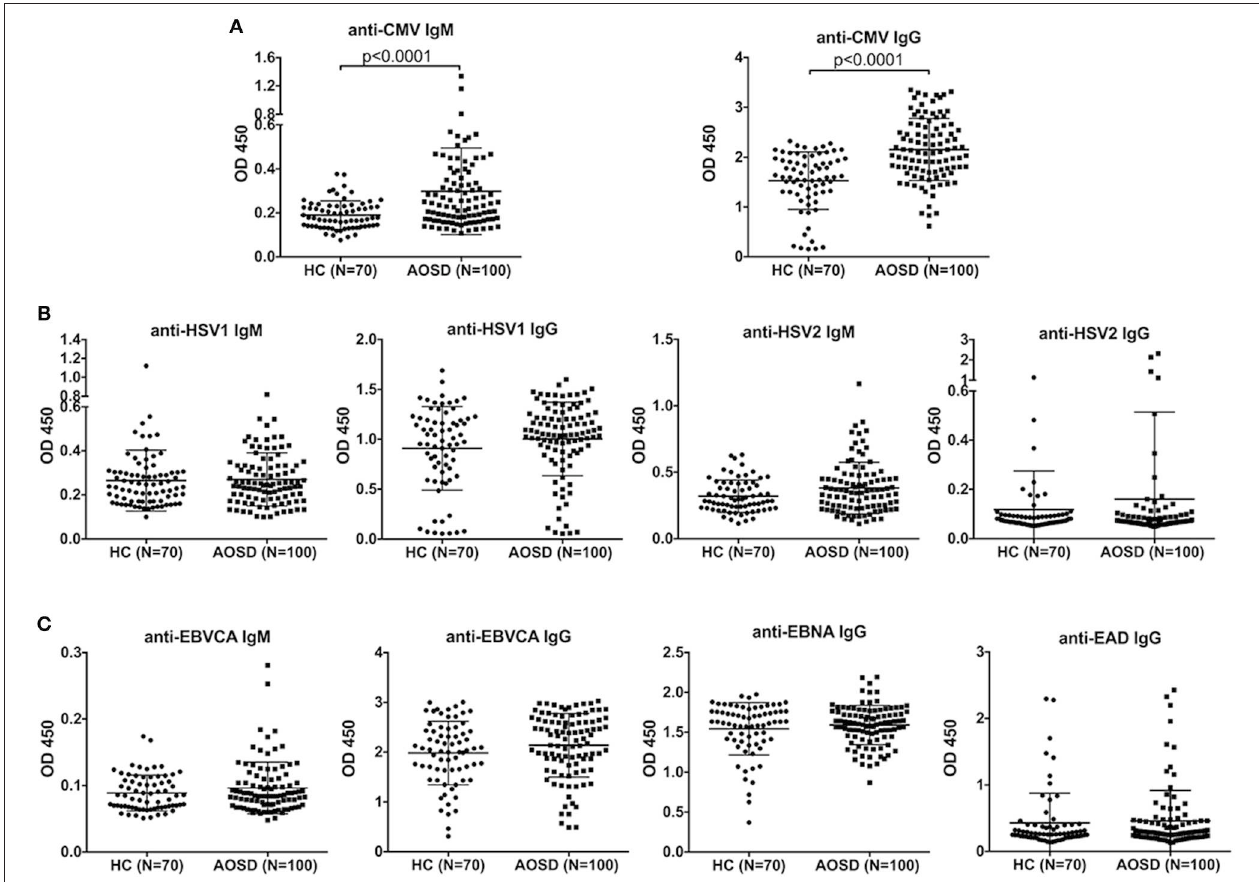
FIGURE 1 | Anti-virus antibody levels in AOSD patients ( N = 100) and HCs ( N = 70). (A) Comparison of antibody levels of anti-CMV IgM and IgG in AOSD patients and HCs. (B) Comparison of IgM and IgG antibody levels against HSV1 and HSV2 in AOSD patients and HCs. (C) Comparison of anti-EBVCA IgM, anti-EBVCA IgG, anti-EBNA IgG, and anti-EAD IgG levels in AOSD patients and HC. Each symbol represents an individual patient with AOSD and a HC. The data represent the mean ± SD by Student’s t -test. CMV, Cytomegalovirus; HSV, Herpes simplex virus; EBVCA, Epstein-Barr virus capsid antigen; EBNA, Epstein-Barr virus nuclear antigen; EAD, Epstein-Barr virus early antigen diffuse.